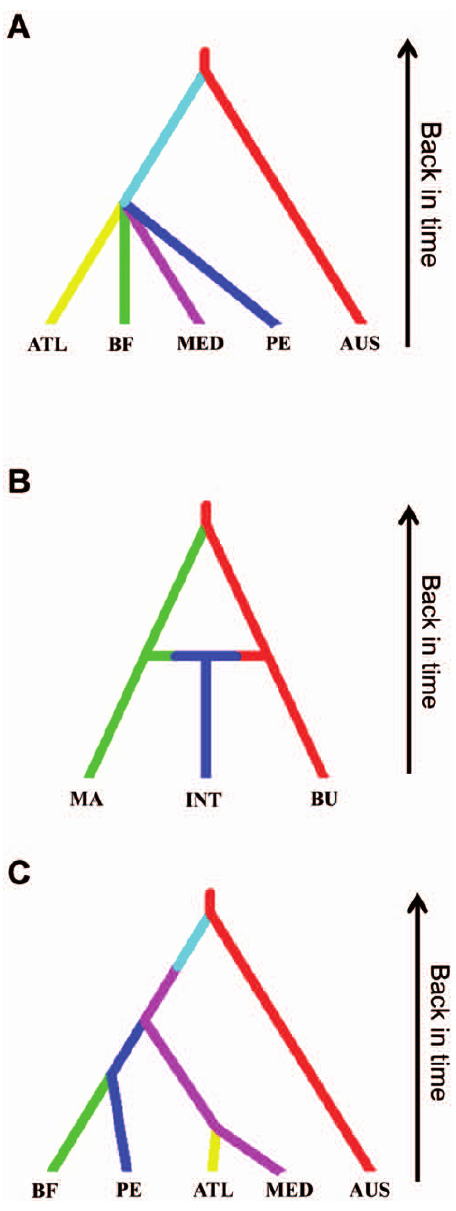
Figure 4. Most-likely scenarios of each set of scenarios using approximate Bayesian computation methods on microsatellite data of Microcosmussquamiger : A) Independent vs non-independent colonisations; B) Origin of colonising populations, indicating the admixture process between the two ancestral populations; C) Sequence of worldwide introductions. The Y-axis indicates the time of events (not to scale). Abbreviations of single and clustered populations are as follows: Bahı´a Falsa (BF), Bunbury (BU), Manly (MA), Port Elizabeth (PE), Introduced (INT), Australian (AUS), NE Atlantic (ATL) and Mediterranean Sea (MED). The unsampled population in A) and C) is indicated by a faint blue colour.